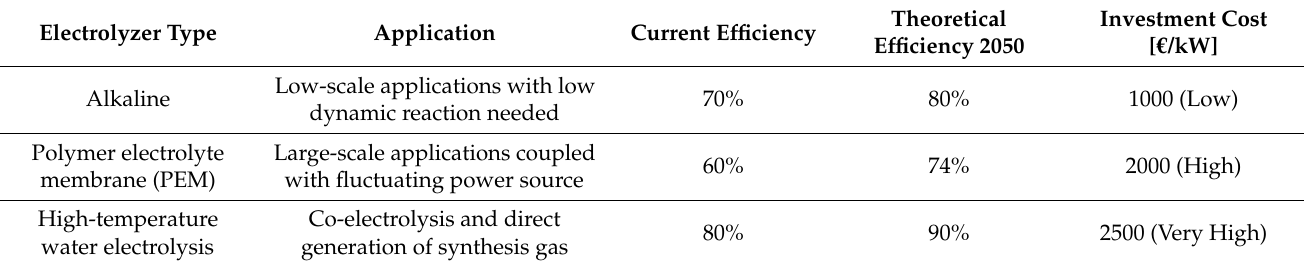
Table 3. Electrolyzer types [39].